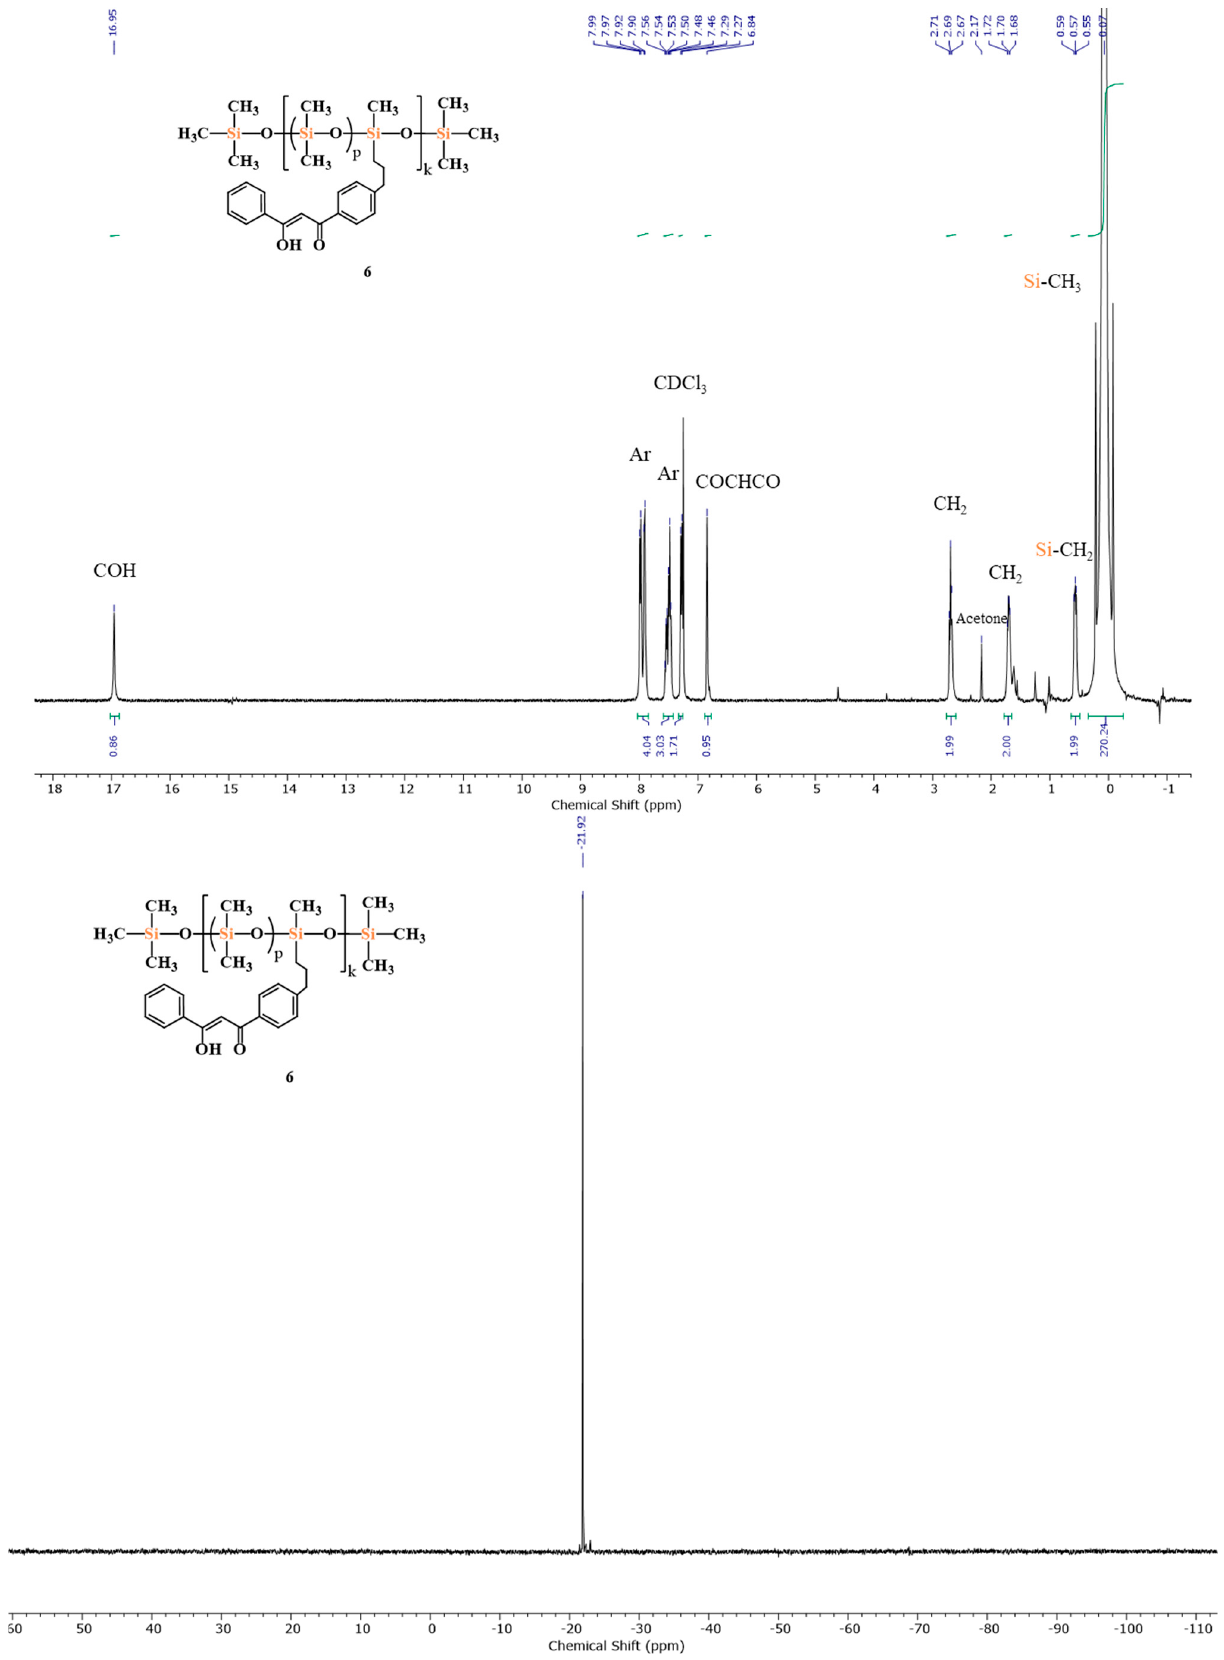
Figure 5. The 1 H ( top ) and 29 Si ( bottom ) NMR spectra of polymer 6 in CDCl 3 .